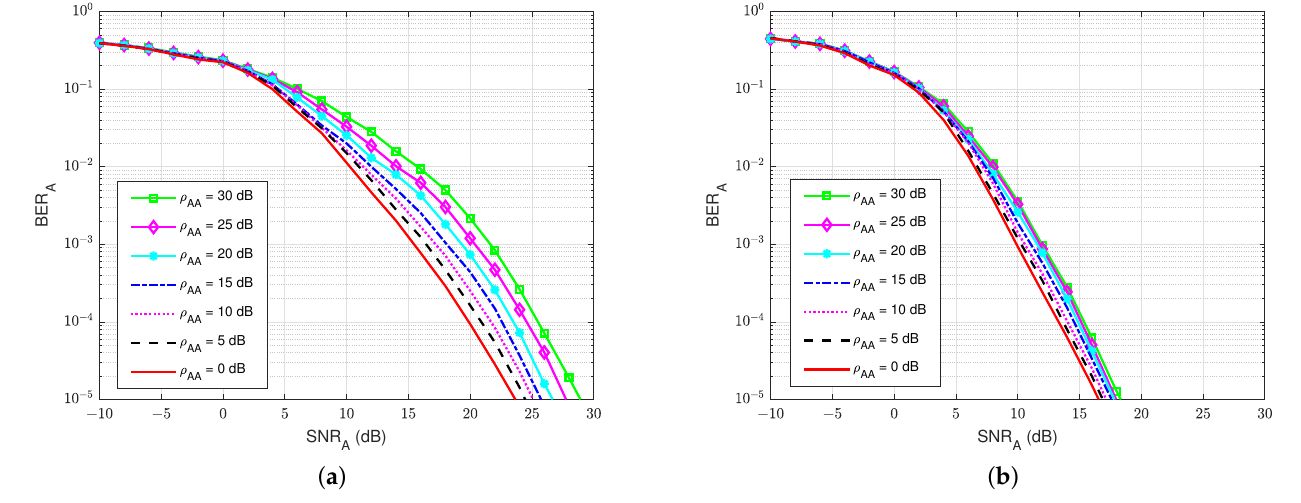
Figure 10. BER A versus SNR A in case of a passive eavesdropper: ( a ) Blind without feedback; ( b ) Blind